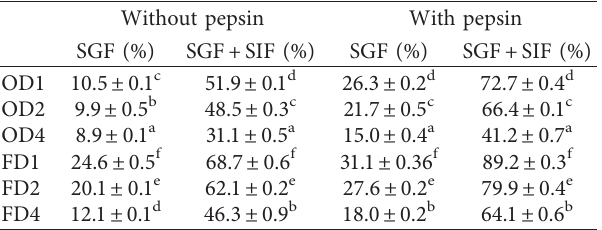
Results are expressed as mean ± standard deviation ( n � 3). Means in the same column with different letters are significantly different based on Duncan multiple range